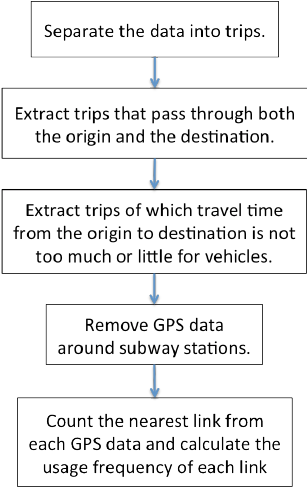
Figure 2. Calculation of link usage frequency